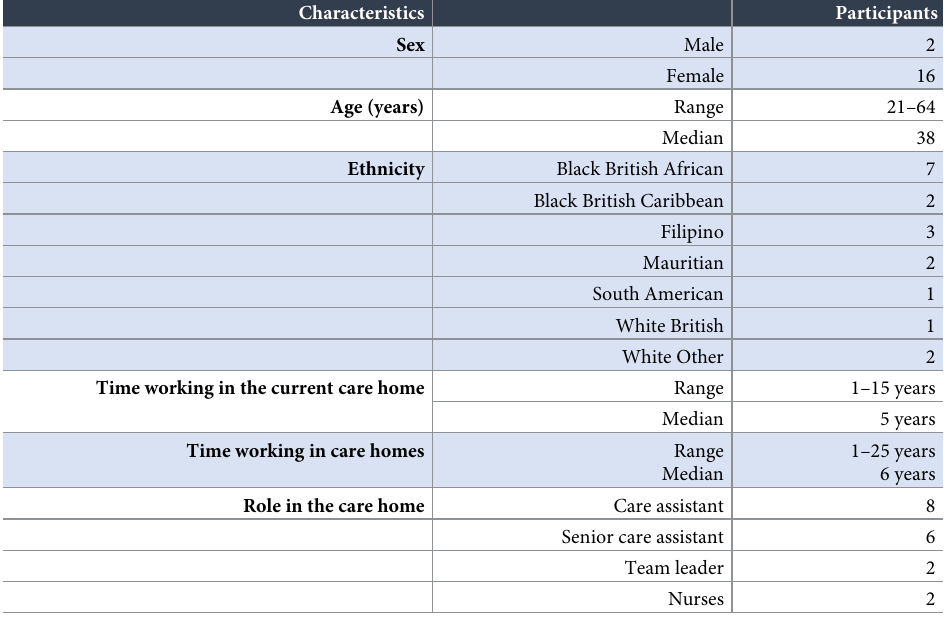
Table 1. Sociodemographic and work-related characteristics of staff participating in the SIESTA